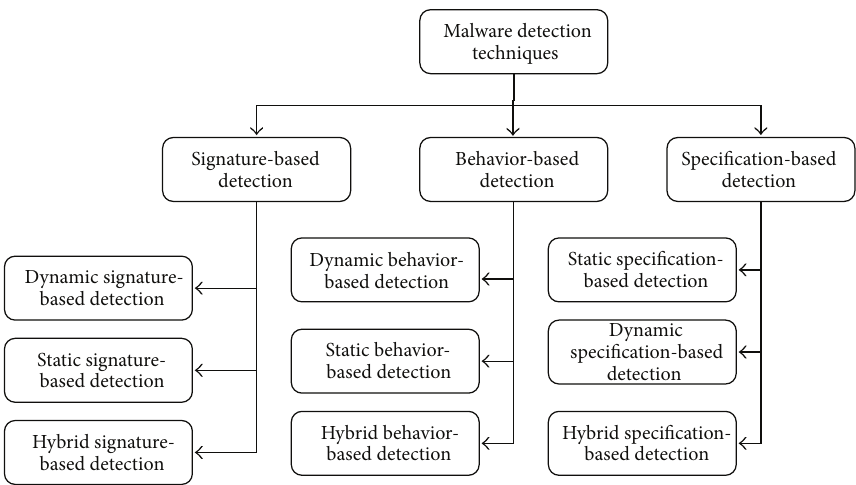
Figure 5: A classification of Smartphone malware detection techniques.